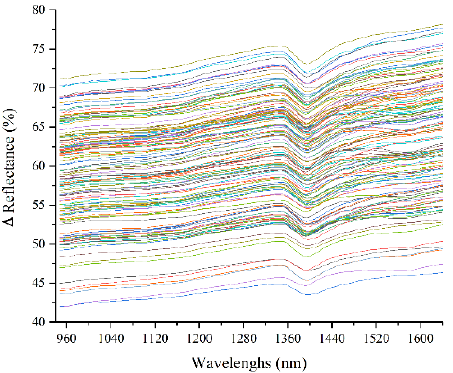
Figure 2. Original spectra showing the available nitrogen content of vermiculite substrates.